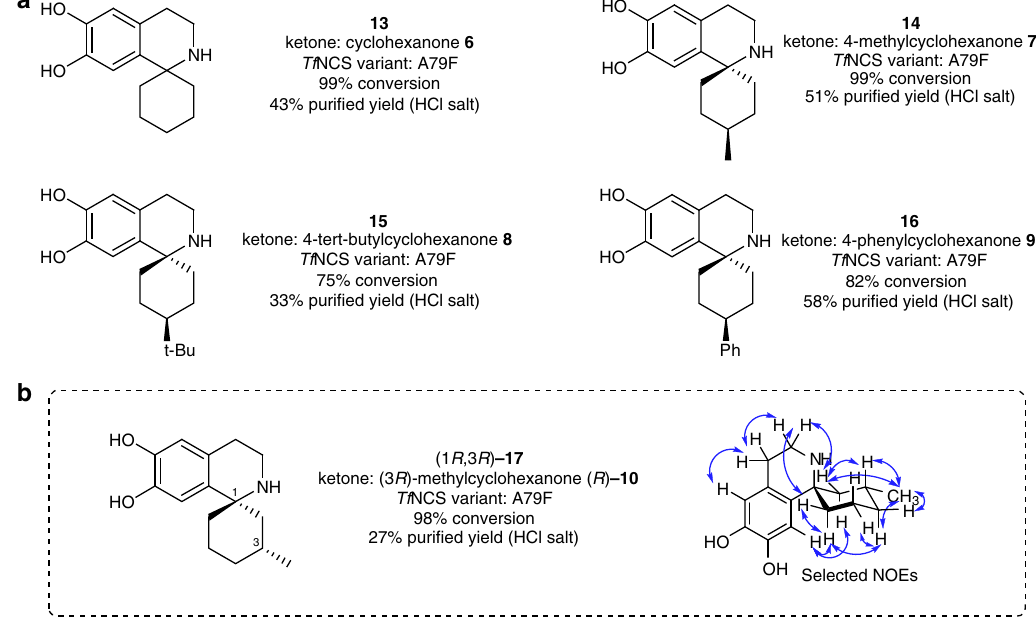
Figure 6 | Biocatalytic formation of spiro-1,1 0 -disubstituted THIQs using D 29 Tf NCS variants. ( a ) Spiro-THIQ products isolated from biotransformations. All compounds feature a fixed stereocentre at the C-4 position. ( b ) Chiral ( R )-Spiro-THIQ product (1 R ,3 R )- 17 isolated from biotransformation. Important NOE (nuclear Overhauser effect) correlations are highlighted. See Supplementary Methods for full synthetic procedures, Supplementary Figs 9 and 10 for HPLC analysis and Supplementary Figs 14-18 for NMR